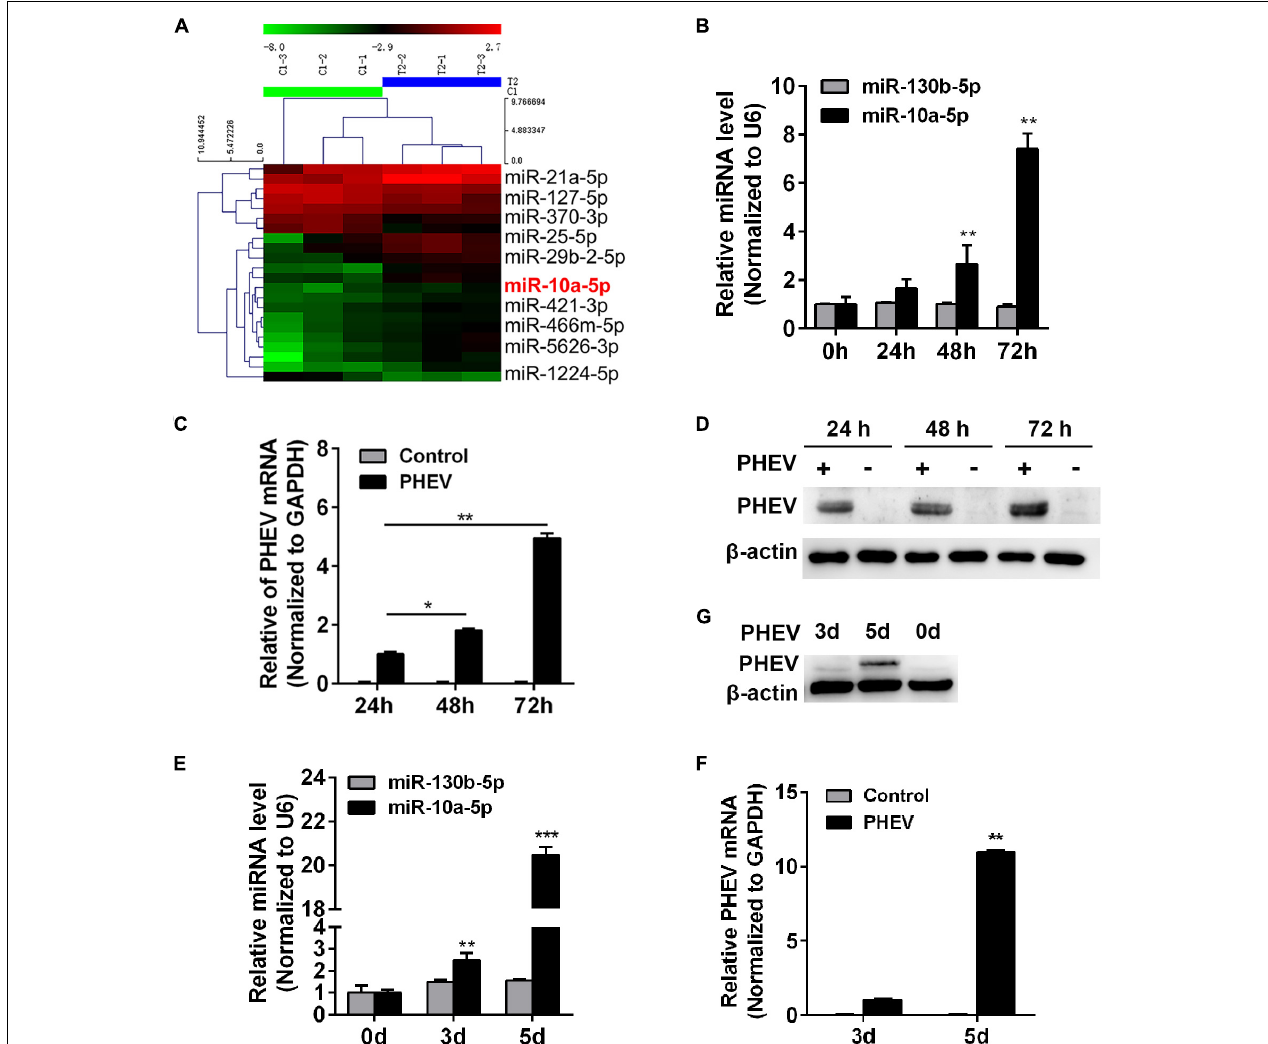
FIGURE 1 | Porcine hemagglutinating encephalomyelitis virus (PHEV) infection up-regulates miR-10a-5p expression. (A) MiRNA array of PHEV-infected and uninfected mice. Hierarchical clustering shows distinguishable miRNA expression profiling among samples. (B) N2a cells were infected with PHEV at 2 × 10 6 TCID 50 /ml and harvested at 0, 24, 48, and 72 h post infection. The expression of miR-10a-5p was determined by qRT-PCR. U6 was chosen as a housekeeping gene to normalize miR-142a-3p expression. Another irrelative miR-130b-5p is used as a negative control. (C) Cells were treated as described in panel (B) , then the total RNA was extracted, and the relative expression of PHEV mRNA was determined by qRT-PCR. Data were normalized to GAPDH. (D) N2a cells treated as described in panel (B) , and the cell lysates were collected and subjected to examine the expression of PHEV protein by western blotting. Beta actin expression was verified as loading control. (E) BALB/c mice were infected with PHEV for 3 or 5 days, and then the cerebral cortexes were harvested, and miR-10a-5p level was determined by qRT-PCR. N = 4 mice per group, three independent experiments. (F) The lysis from cerebral cortexes of mice as described in panel (E) was collected, and then the relative expression of PHEV mRNA was determined by qRT-PCR. (G) The cerebral cortical lysis was detected by western blotting, and the PHEV protein was normalized to beta actin. All of data are representative of at least three independent experiments, with the error bars representing the standard deviations (SDs). * p < 0.05, ** p < 0.01 vs. normal